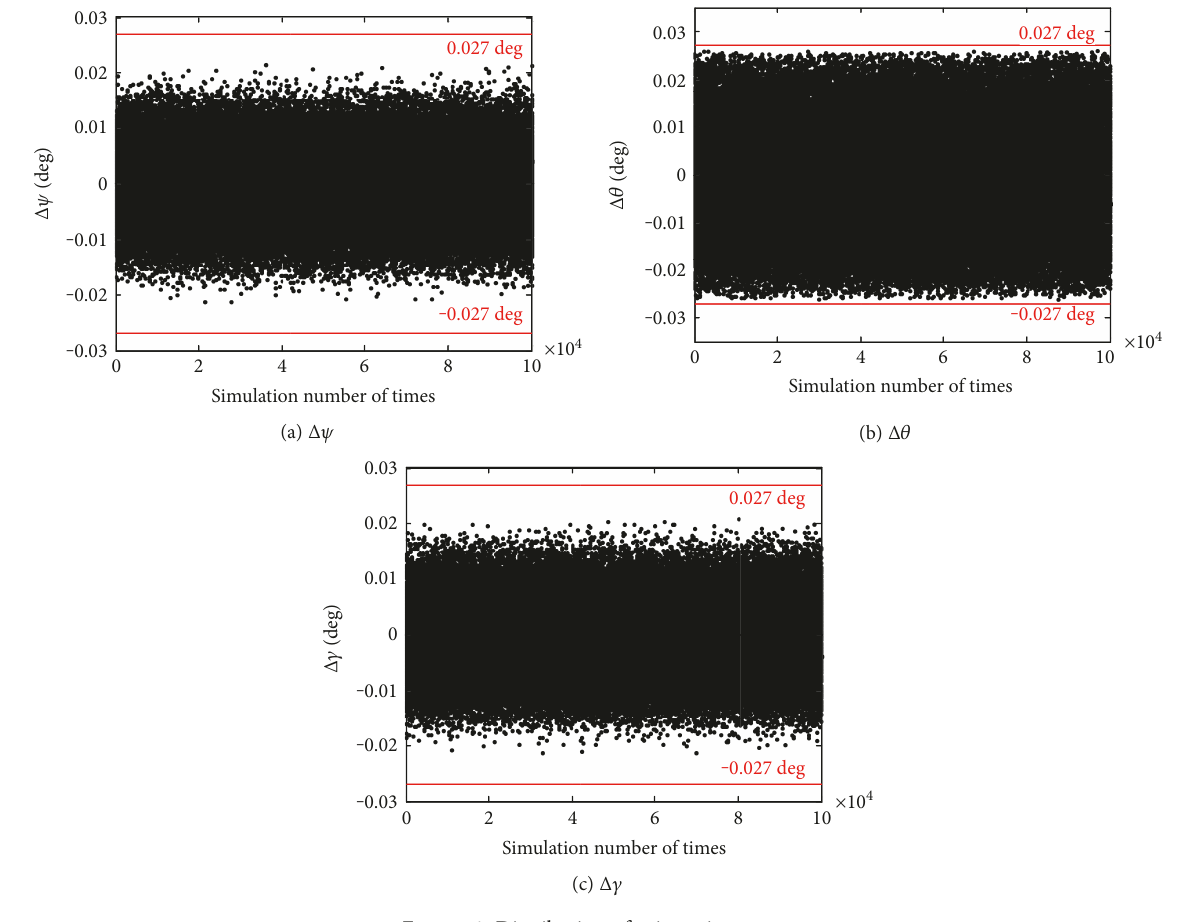
Figure 9: Distribution of orientation